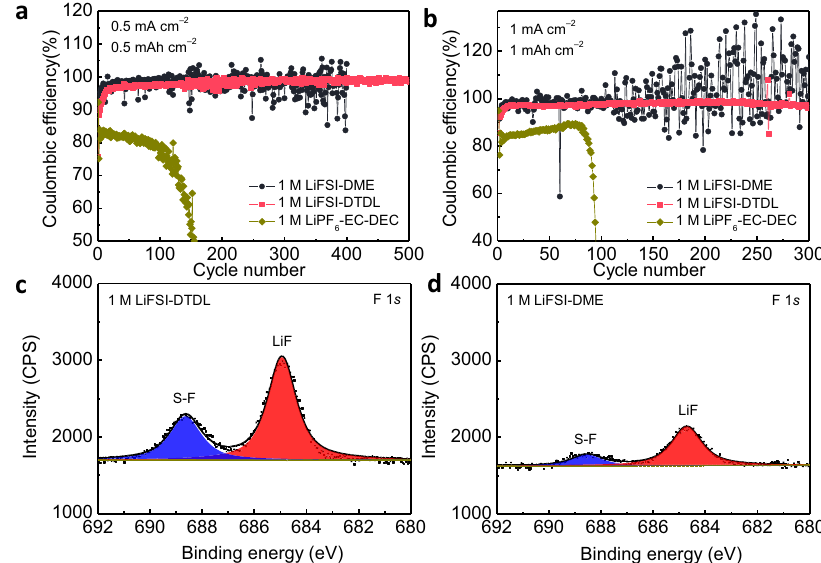
Fig. 3 Cycling performance and SEI compositions of Li|Cu half cells. Cycling stability of Li|Cu half cells using different electrolytes at 0.5 mA cm − 2 with a cutoff capacity of 0.5 mAh cm − 2 ( a ) and 1 mA cm − 2 with a cutoff capacity of 1 mAh cm − 2 ( b ). F 1 s XPS pro fi les on plated Li metal surface in Li|Cu half cells in 1 M LiFSI-DTDL ( c ) and 1 M LiFSI-DME ( d ) electrolytes after 5 cycles at 1 mA cm − 2 with a cutoff capacity of 1 mAh cm − 2